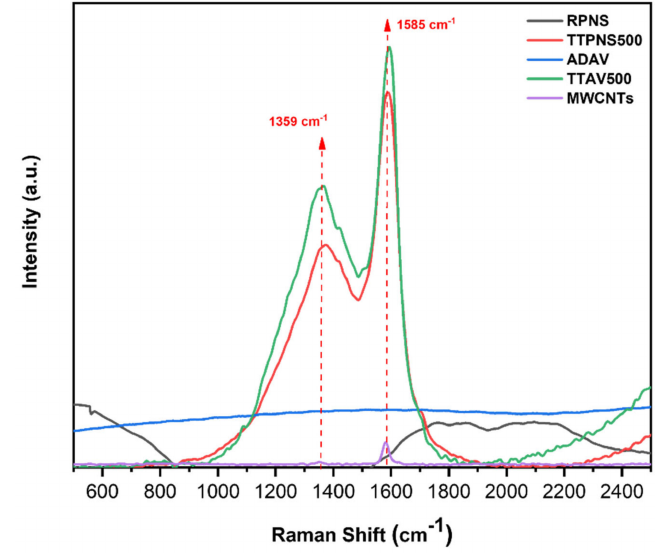
Figure 8. Raman spectra of the tested